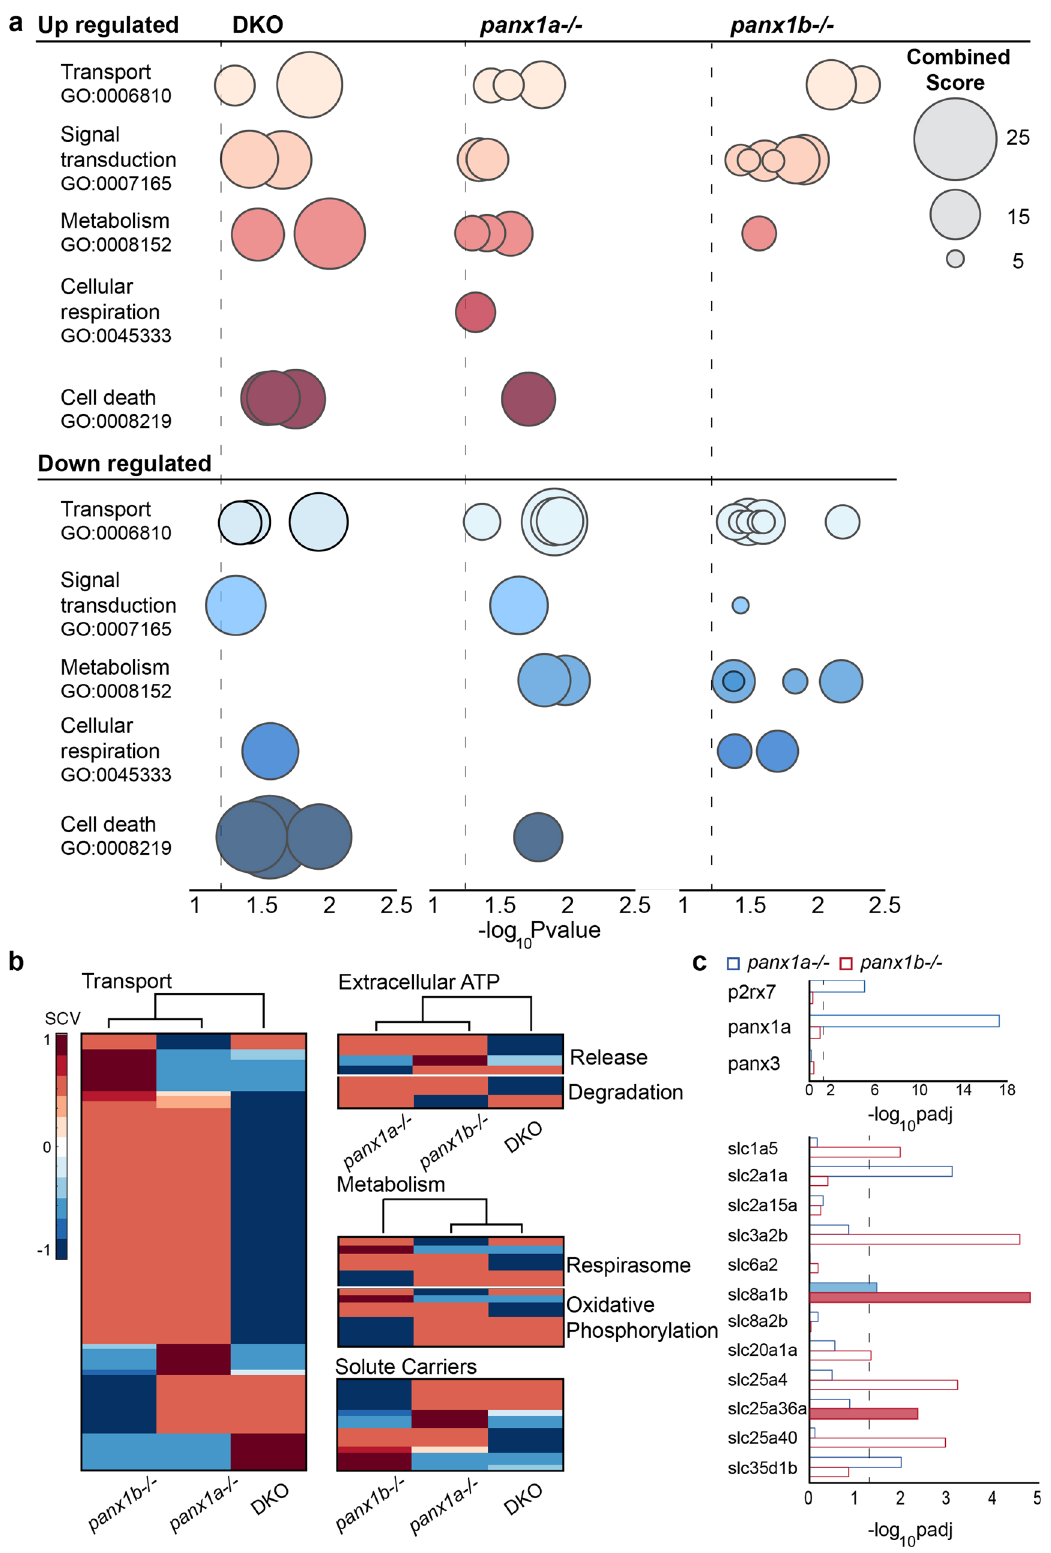
(Fig. 9c) versus a staggered packing observed in the original cryo- EM structure, increasing the diameter of the gate from 8.1 to 10.9 A. While the biological signi fi cance of these observed and modeled conformations is unknown, it demonstrates that side-chain motions may limit the size of the extracellular facing gate in the absence of backbone conformational